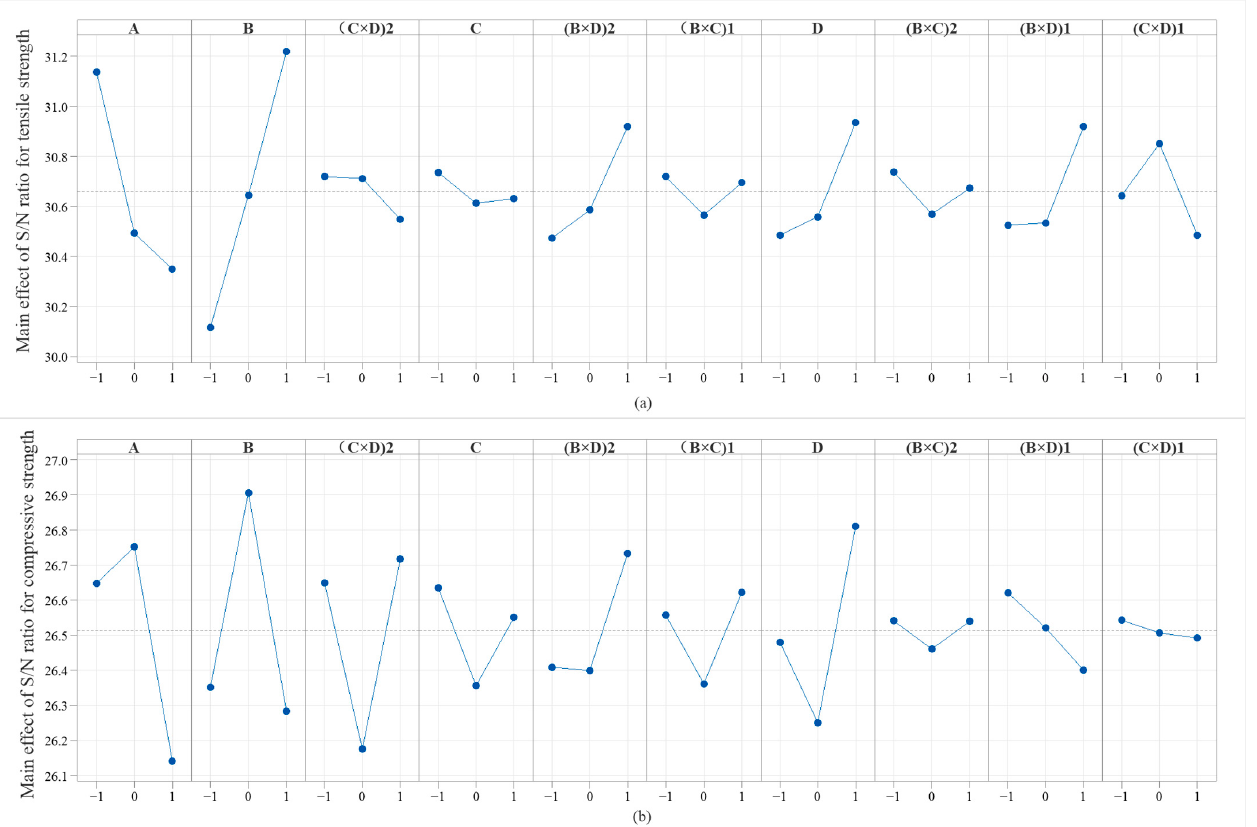
Figure 4. Main effect graph by Taguchi method: ( a ) tensile; ( b ) compressive.